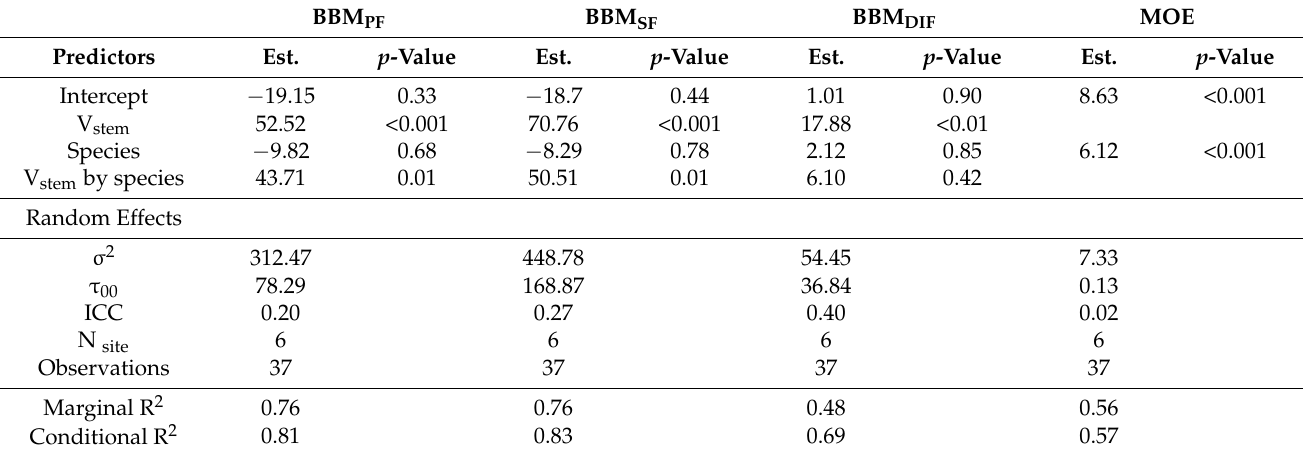
Table 3. Statistics of the linear mixed-effects models relating basal bending moment of aspen and birch growing in forest at the primary (BBM PF ) and secondary (BBM SF ) failures and the difference between them (BBM DIF ), and the modulus of elasticity (MOE) of aspen and birch stems under static loading. BBM